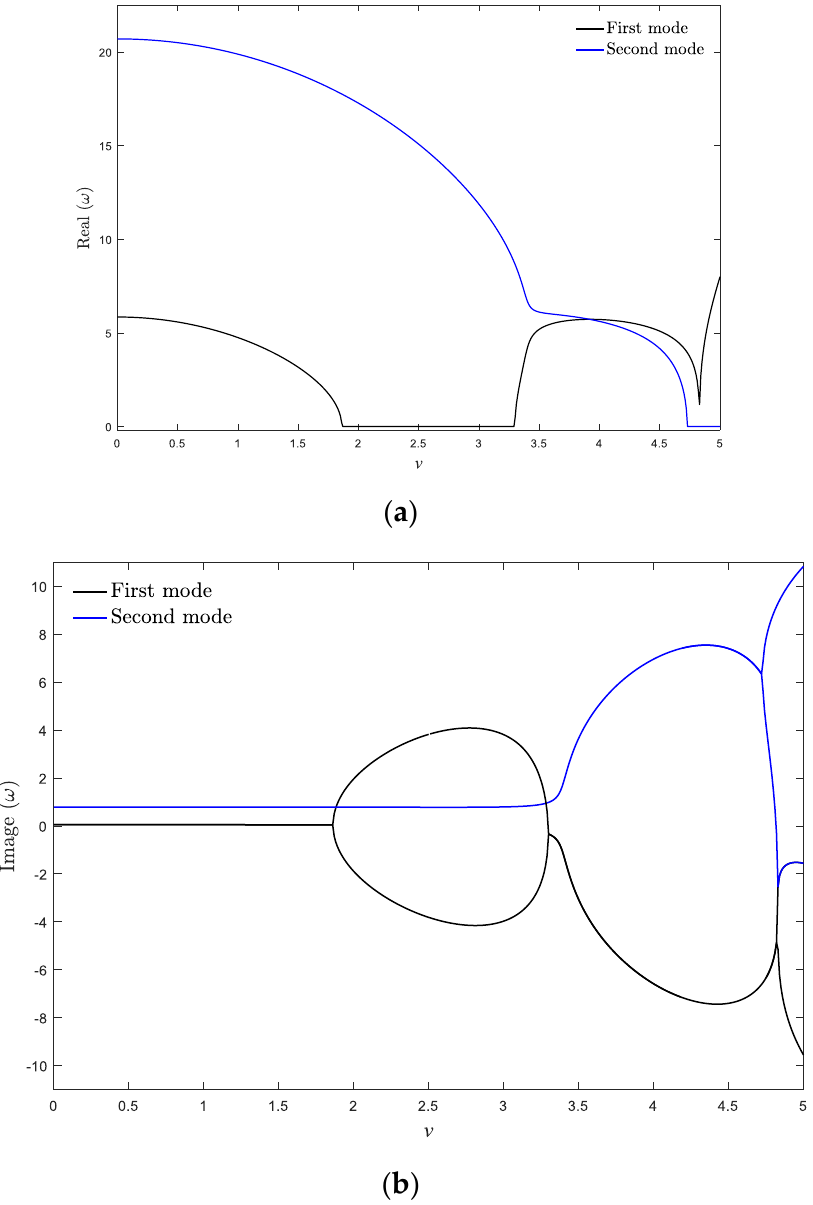
Figure 15. ( a ) Real and ( b ) imaginary parts of two natural frequencies of a viscoelastic moving = 0.5, µ = 0.025, ζ = isotropic nanobeam for k f = 0.5, µ = 0.025, ζ = 0.001. nanobeam for k f